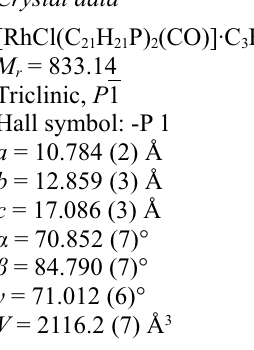
Figure 1 ? trans -Carbonylchloridobis(tri- p -tolylphosphine)rhodium(I) acetone solvate Crystal